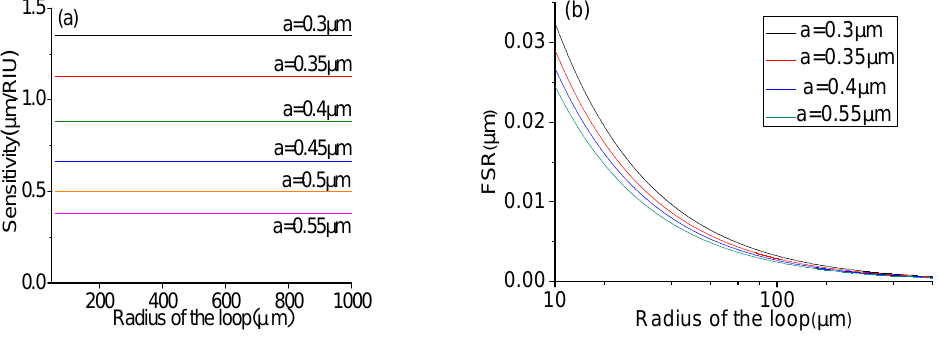
Figure 2. (a) Sensitivity versus the radius of the loop R and the radius of the microfiber a , the unit of sensitivity is µ m per refractive index unit (RIU) (b) FSR versus the radius of the loop R and the radius of the microfiber a